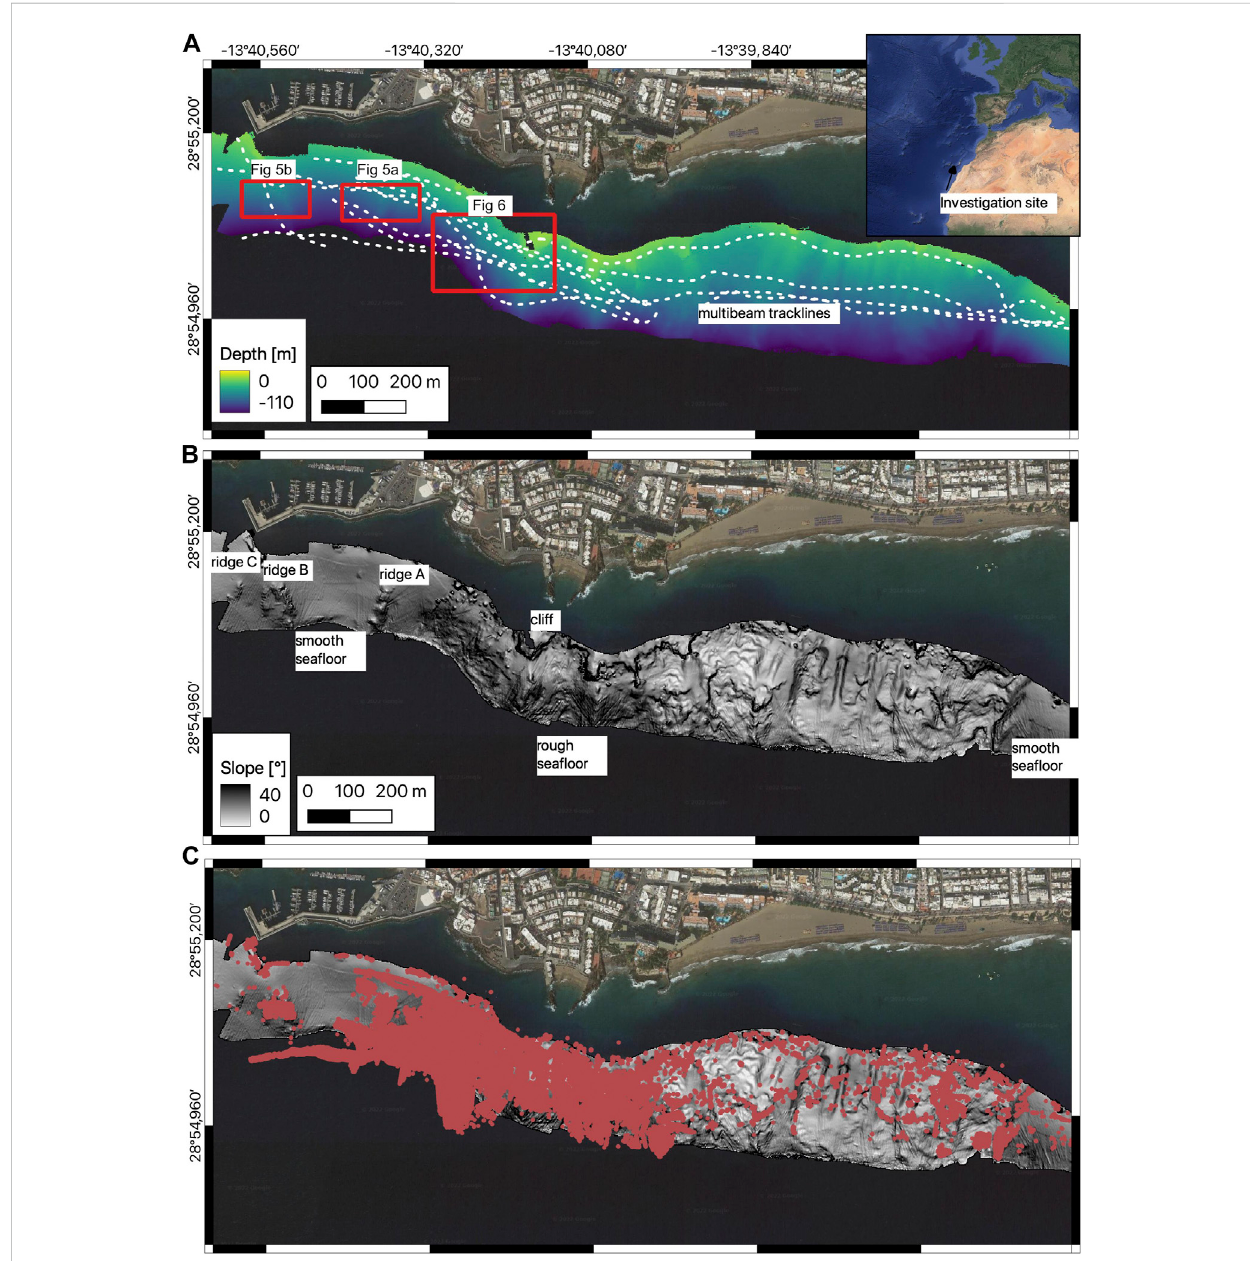
FIGURE 2 (A ) Bathymetric map of the investigation site. Dashed white lines show tracklines acquired for survey with the MD algorithm. (B) Slope map of the investigation site. The location of a steep cliff, and the ridges A, B and C are indicated. (C) Plot of raw MD.